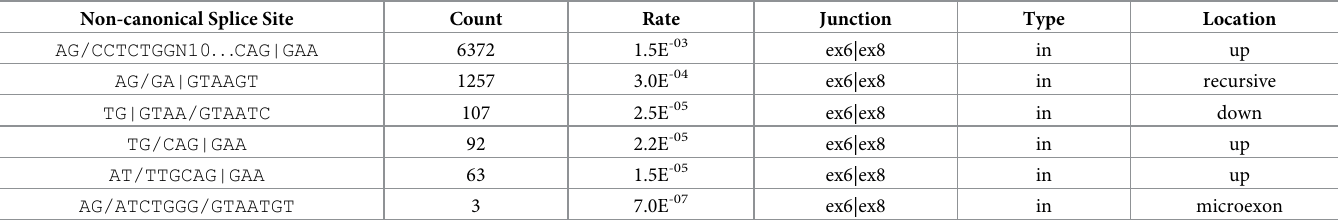
Table 8. Skipped exon 7 cryptic splicing.